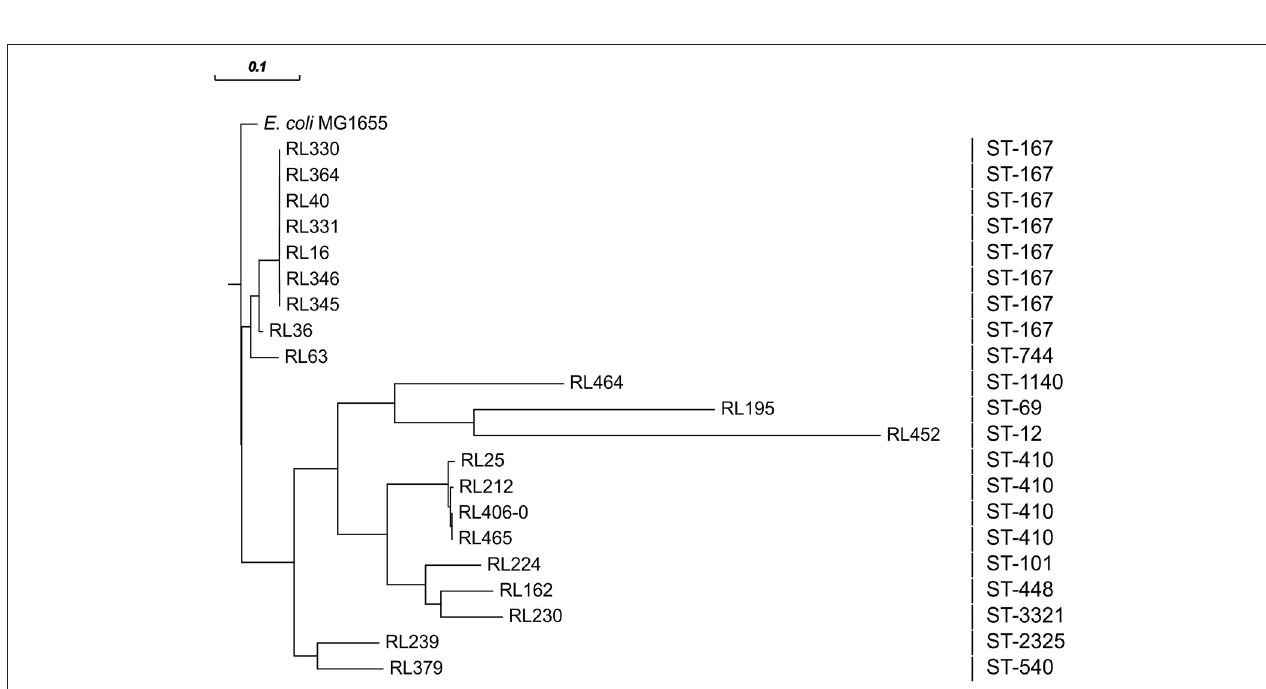
FIGURE 2 | Phylogenetic analysis of all 21 sequenced CTX-M-15-producing isolates obtained from food performed by HarvestSuite (ParSNP), using E. coli MG1655 (NC_000913) as a reference. The scale defines the degree of the phylogenetic relationship of the isolates.